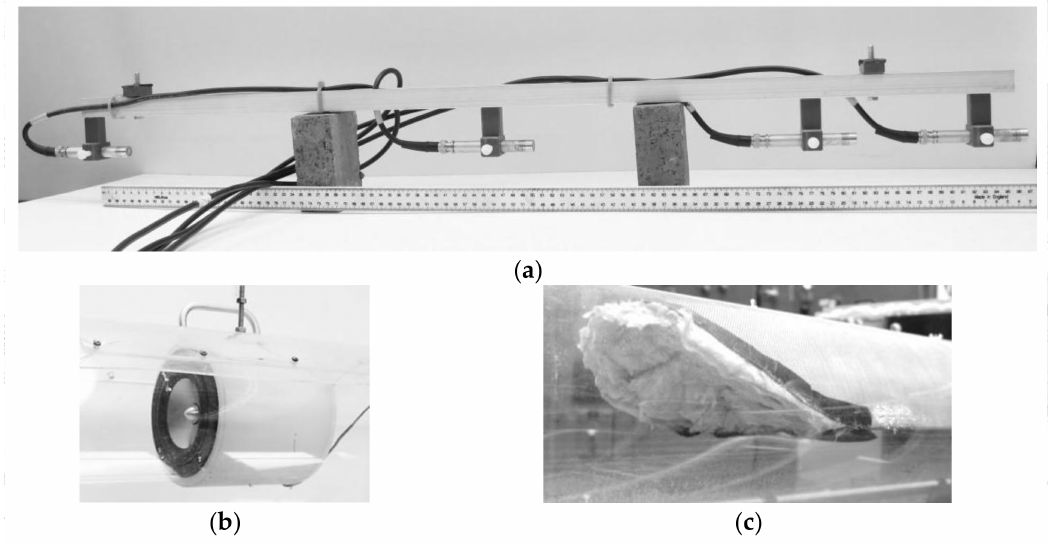
Figure 4. Microphone on a steel bracket ( a ); speaker attached to the pipe top ( b ); sound absorbent occupying top half of pipes cross section at pipe outlet ( c